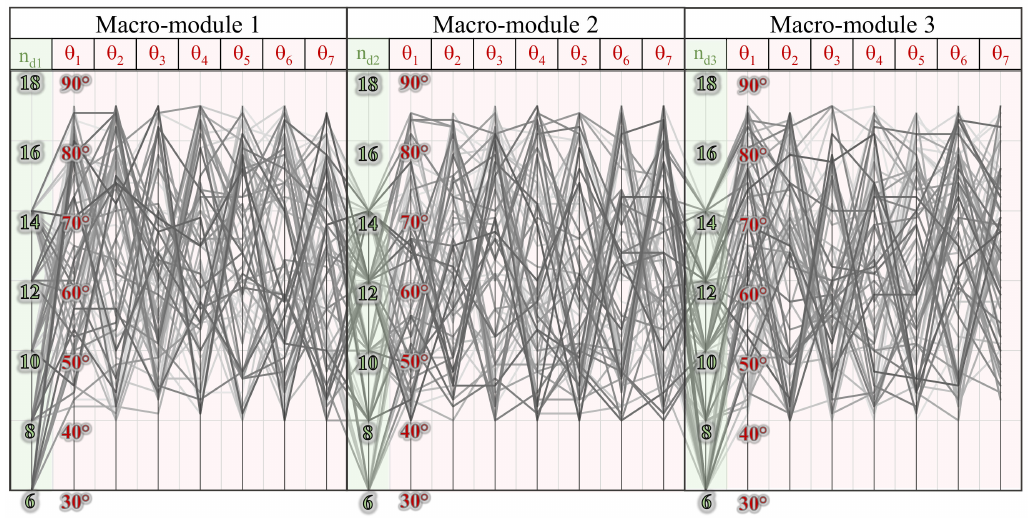
Figure 10. Generative design: parallel coordinates plot for H/B = 6.6: all solutions.